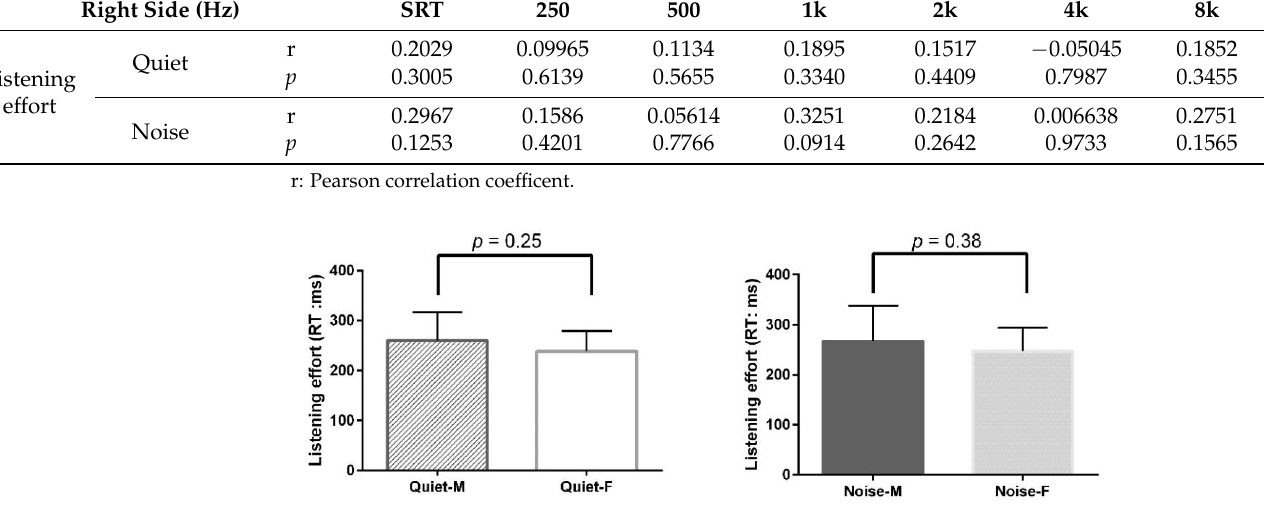
Figure A3. Comparison of Listening effort between male (14) and female (14) subjects. Quiet male: 260.62 ± 55.82 ms, Quiet female: 238.97 ± 39.98 ms, ( p = 0.25); Noise male: 267.40 ± 69.69 ms, Quiet female: 247.15 ± 47.12 ms, ( p = 0.38).